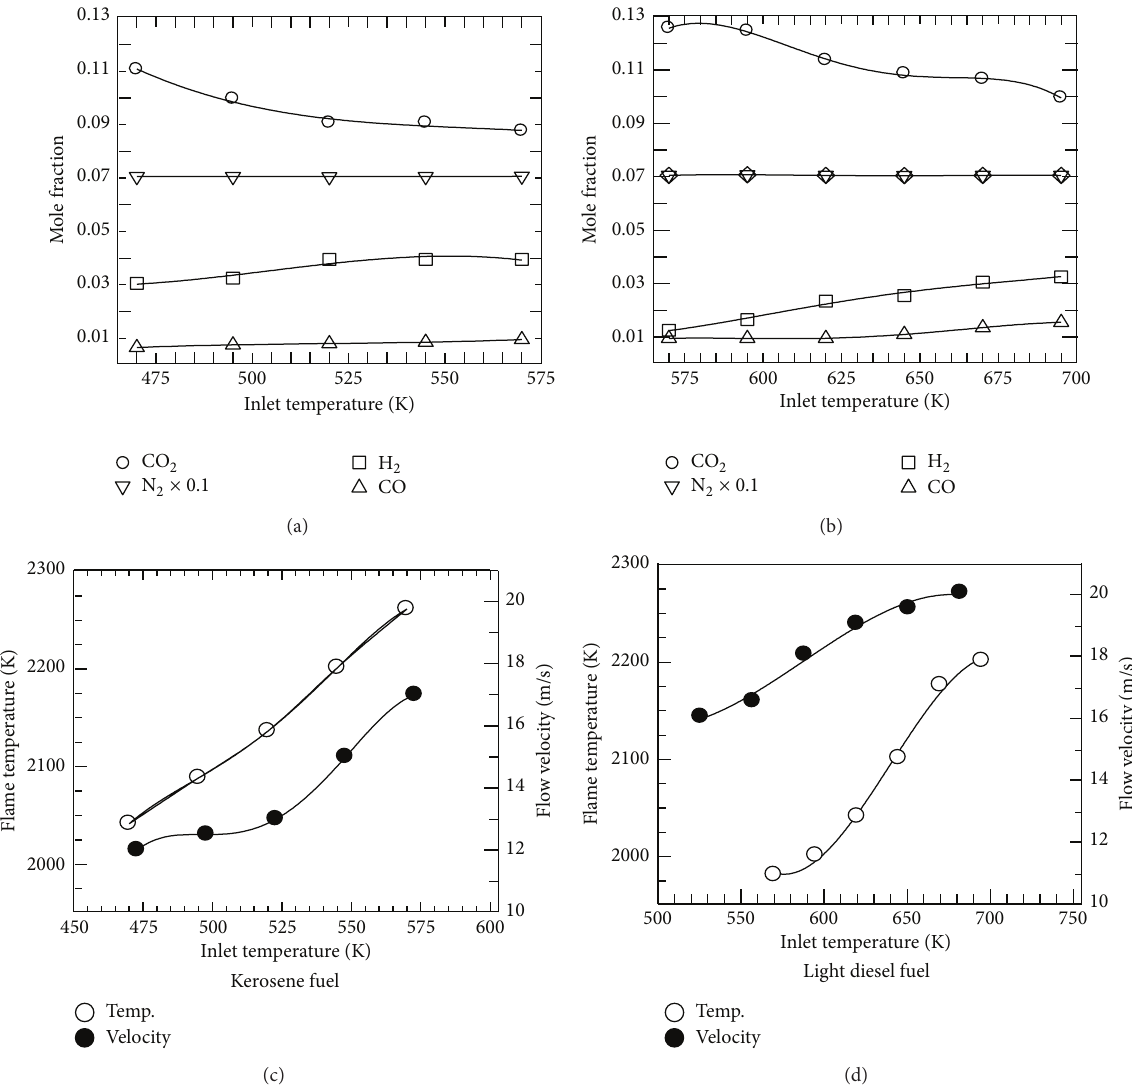
Figure10:Effectofinlettemperatureonflamestructureforturbulentpremixedairflameatresidencetime7 ms,Reynoldsnumber 11.08×10 3 , solidity ratio 0.68, equivalence ratio 1.13, and pressure 1